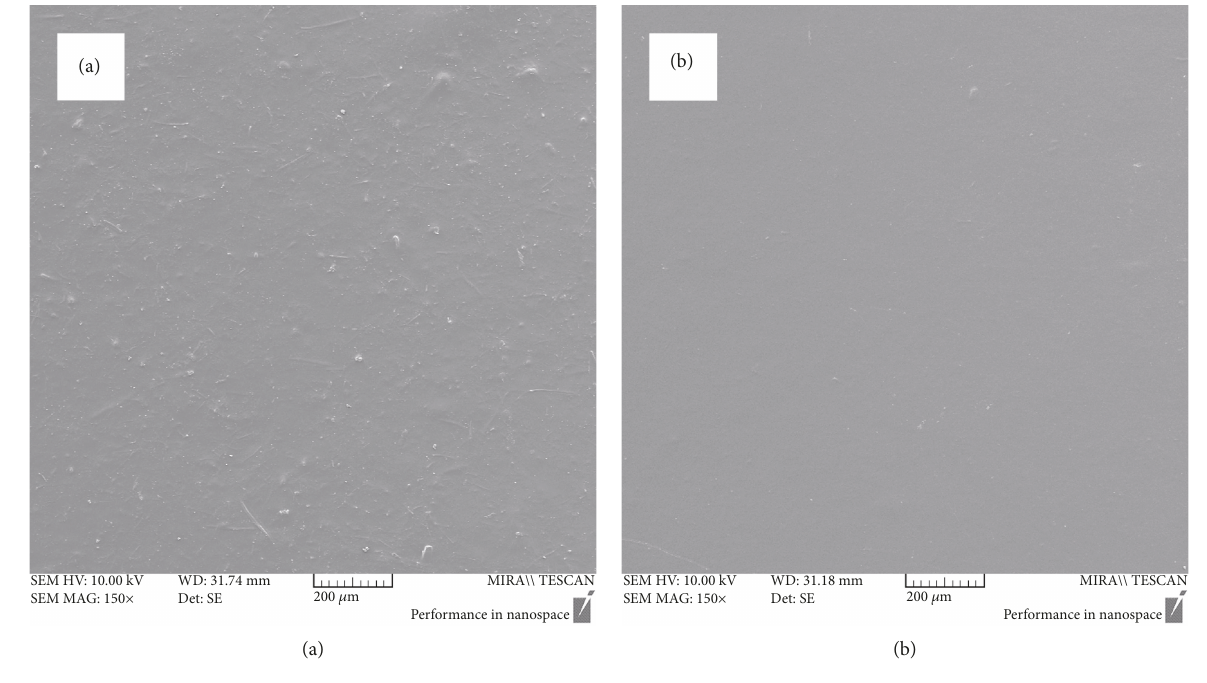
Figure 7: Surface morphology of neat CA fi